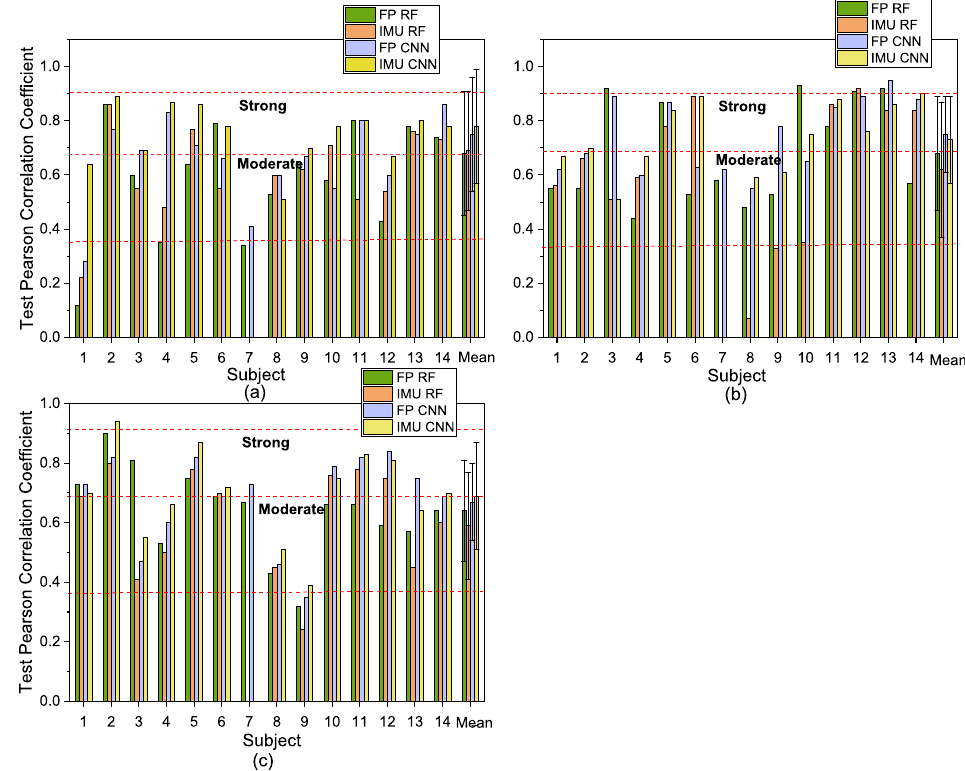
Figure 6. Results with IMU only and force plate (FP) only in the RF and CNN models: ( a ) squat; ( b ) high knee jack; ( c ) corkscrew